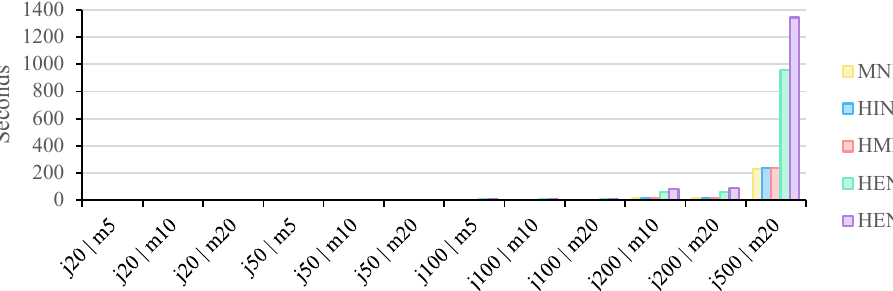
Fig. 8. Graphs of construction heuristics’ execution times with preventive maintenance policy 2